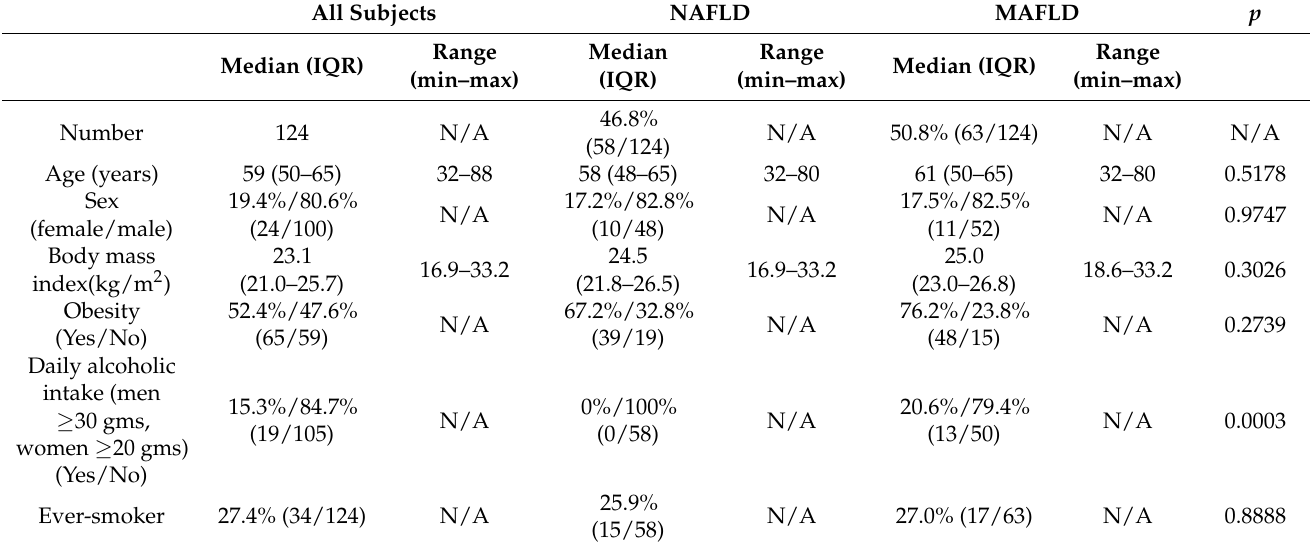
Table 1. Patients’